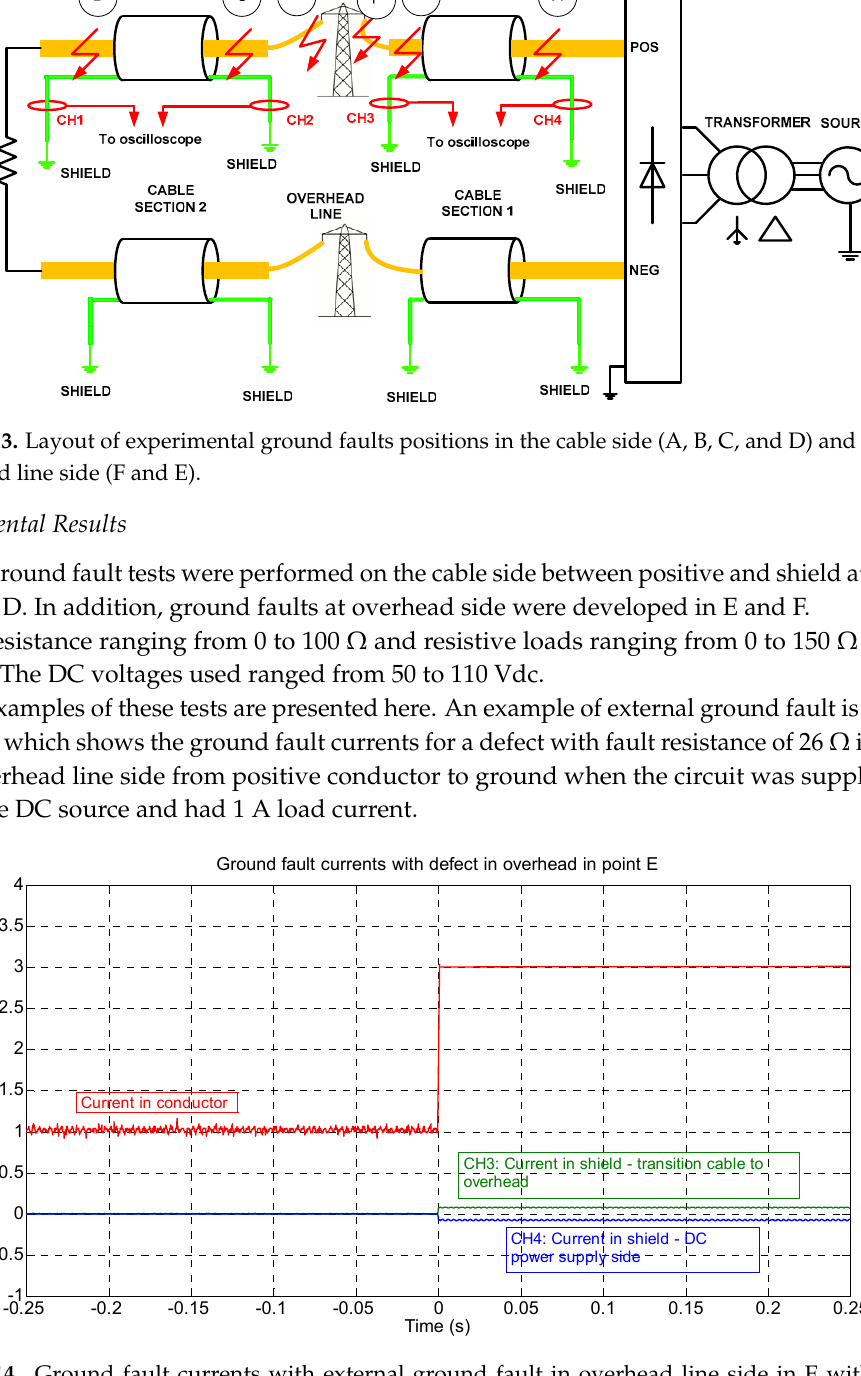
Figure 12. Experimental set-up. 1: AC power supply; 2: oscilloscope; 3: rectifying bridge; 4: current measurement units; 5: fault switch; 6: cable and shield modules; 7: load resistor; 8: fault resistance; 9: overhead line modules.